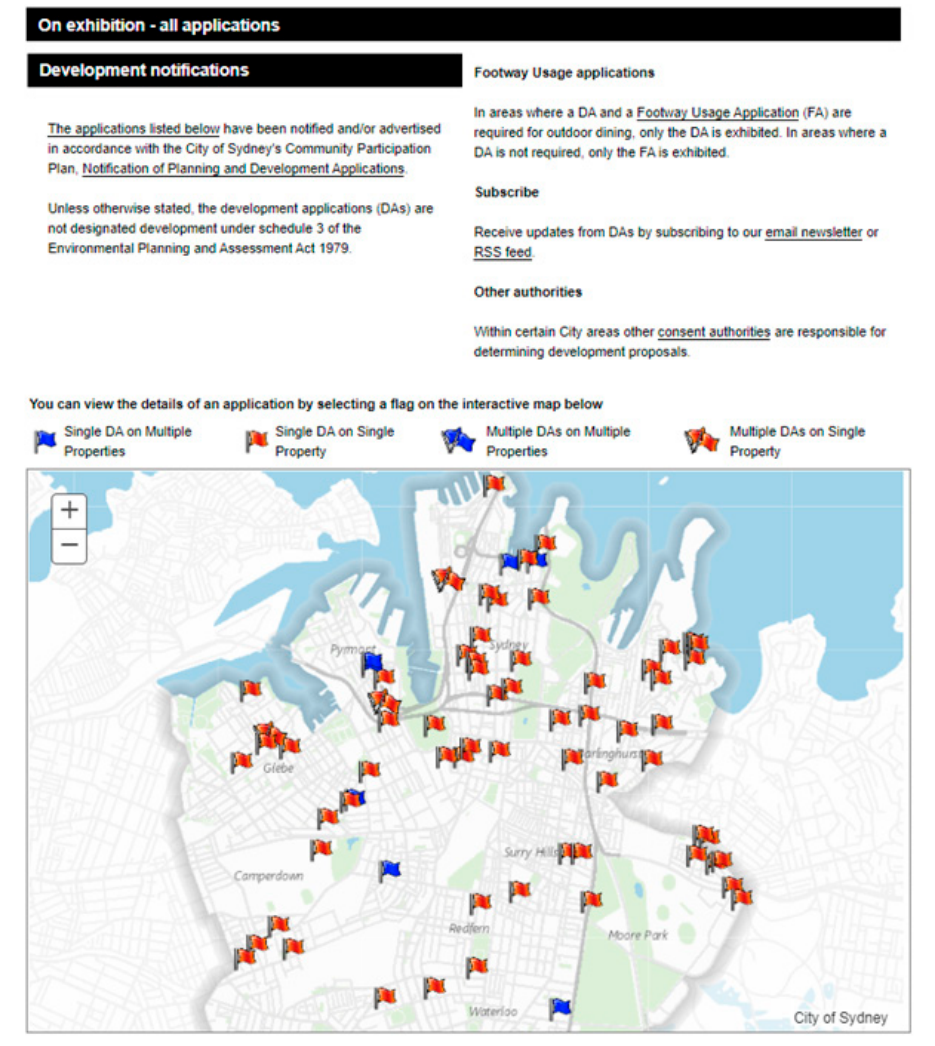
Figure 4. Snapshot of CoS Council website ‘On exhibition’ map (https://online2.cityofsydney.nsw.gov.au/DA/OnExhibitions, accessed on 3 May 2021).